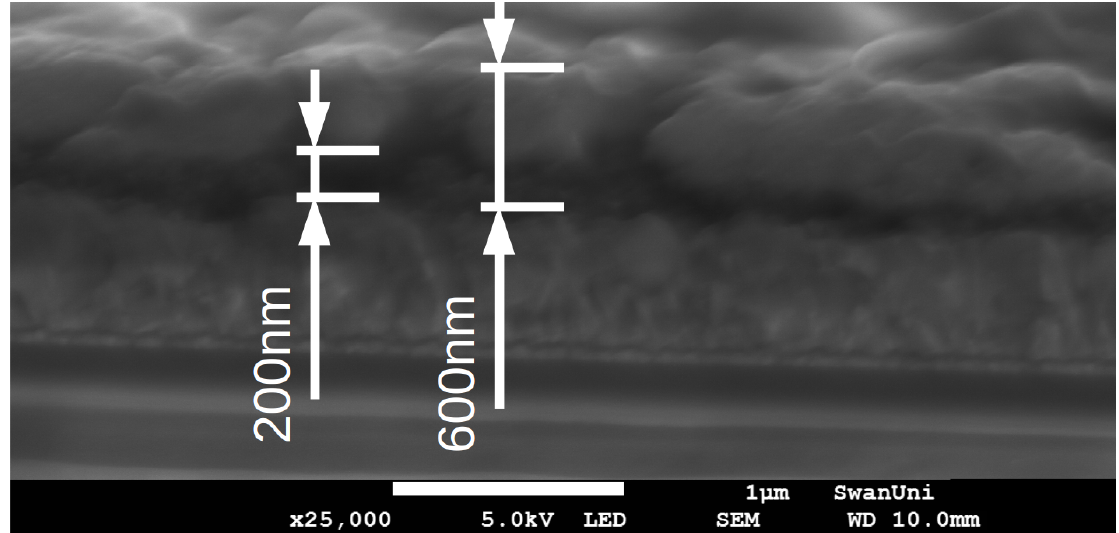
Figure 2. SEM cross section image of slot-die coated lead iodide film, converted to perovskite, on an FTO coated glass substrate with titanium dioxide blocking layer and scaffold. The approximately 200 nm scaffold and 600 nm perovskite layer are marked in the image, the scale-bar in the boarder represents 1